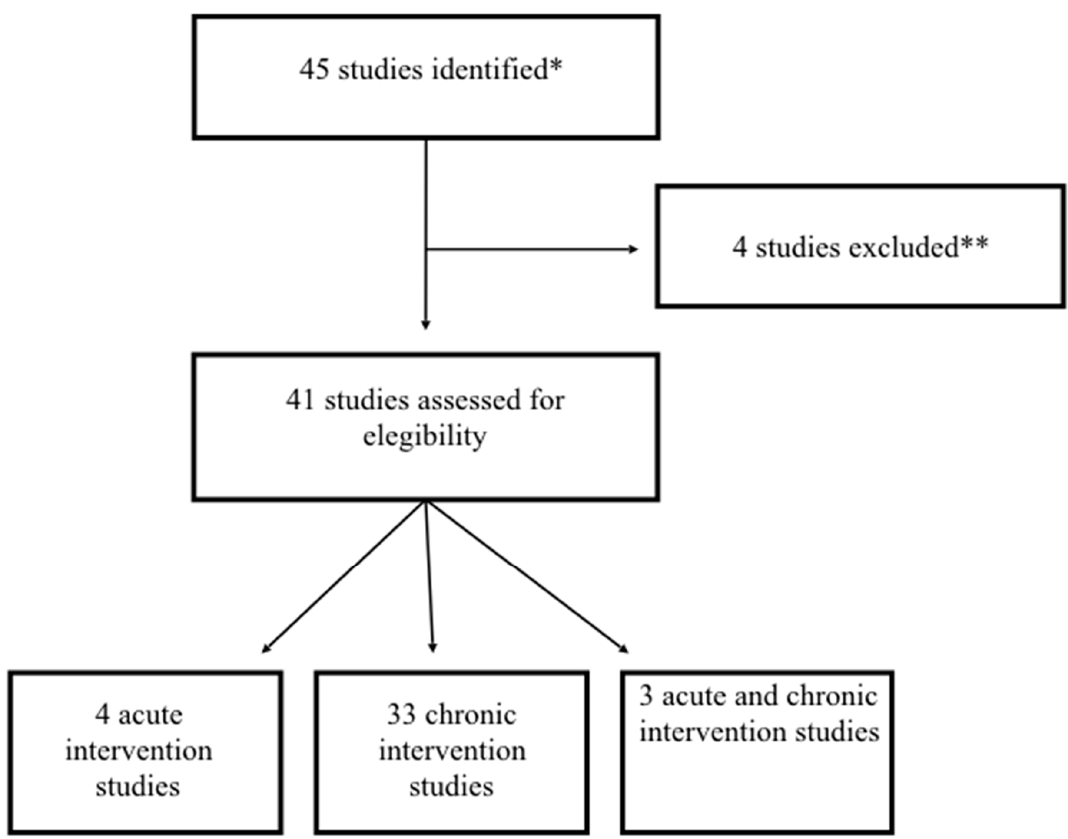
Figure 1 . A flow chart highlighting study selection. * Studies were identified according to the follow- ing keywords: “berry”, “Metabolic Syndrome”, “overweight”, “obesity”, “hypertension”, “hypercho- following keywords: “berry”, “Metabolic Syndrome”, “overweight”, “obesity”, lesterolemia”, “hyperlipemia”, “Type II diabetes”, and “humans”. ** Studies were excluded because they used a mix of fruit and vegetables and other foods in which berries were not the main food.